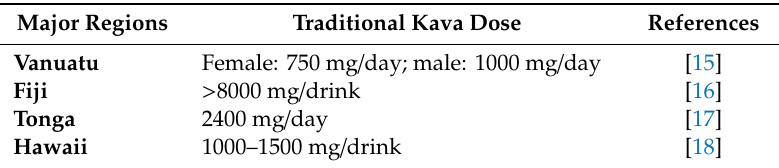
Table 1. Reported dose of kavalactones in traditional kava use.